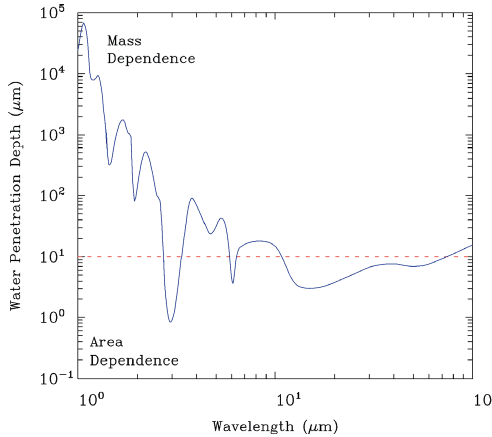
Figure 18. Wavelength dependence for the radiation penetration depth into bulk liquid water. Fig. 18. Wavelength dependence for the radiation penetration depth The horizontal dashed line represents a typical D e value for non-precipitating water clouds. into bulk liquid water. The horizontal dashed line represents a typi- Regions of purely mass and area dependent absorption are indicated. cal D e value for non-precipitating water